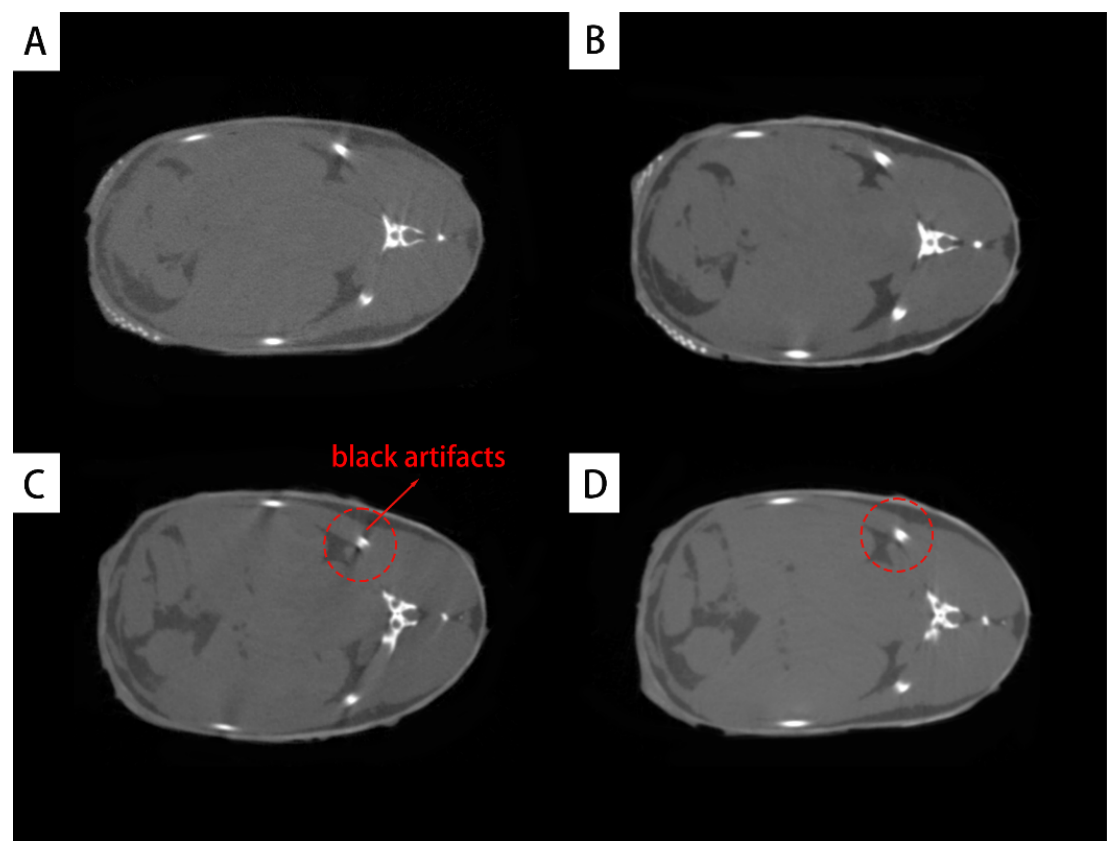
Figure 7. Scanned images of zebrafish at 180°and 360° with different pixels, ( A ) an image scanned at 180° at 4000 pixels, ( B to C ) images scanned at 180° at 2000 pixels in different planes, ( D ) an image scanned at 360° at 2000 pixels ( D ).